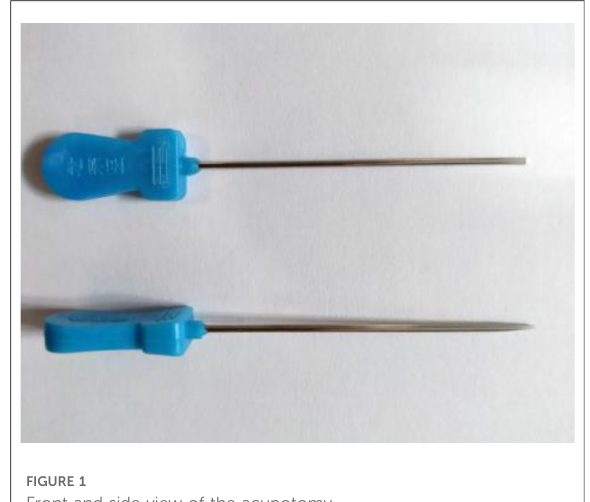
FIGURE 1 Front and side view of the